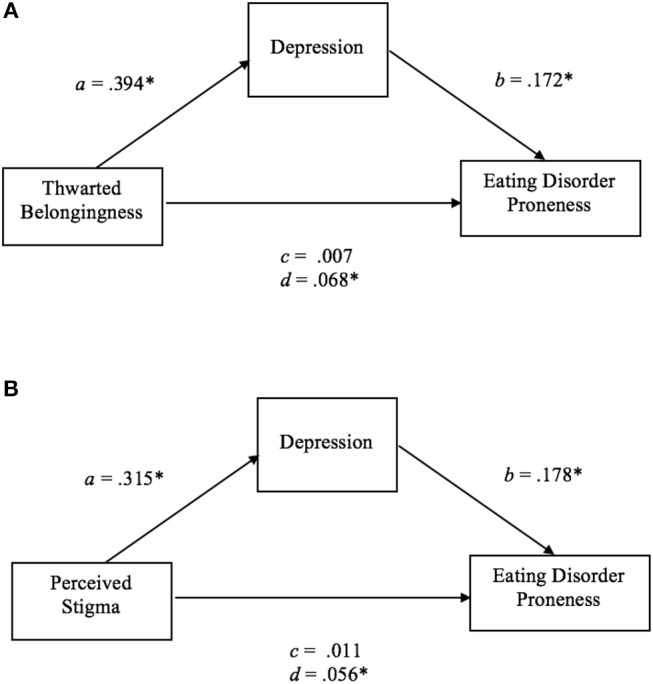
(A) Mediation model of thwarted belongingness on ED proneness in lesbian women. a, the effect of thwarted belongingness on depression; b, the effect of depression on ED proneness; c, the direct effect of thwarted belongingness on ED proneness; d, the indirect effect of thwarted belongingness on ED proneness with bootstrapping (10,000 resamples). n = 58. *p < 0.05. (B) Mediation model of perceived stigma on ED proneness in lesbian women. a, the effect of perceived stigma on depression; b, the effect of depression on ED proneness; c, the direct effect of perceived stigma on ED proneness; d, the indirect effect of perceived stigma on ED proneness with bootstrapping (10,000 resamples). n = 55. *p < 0.05.